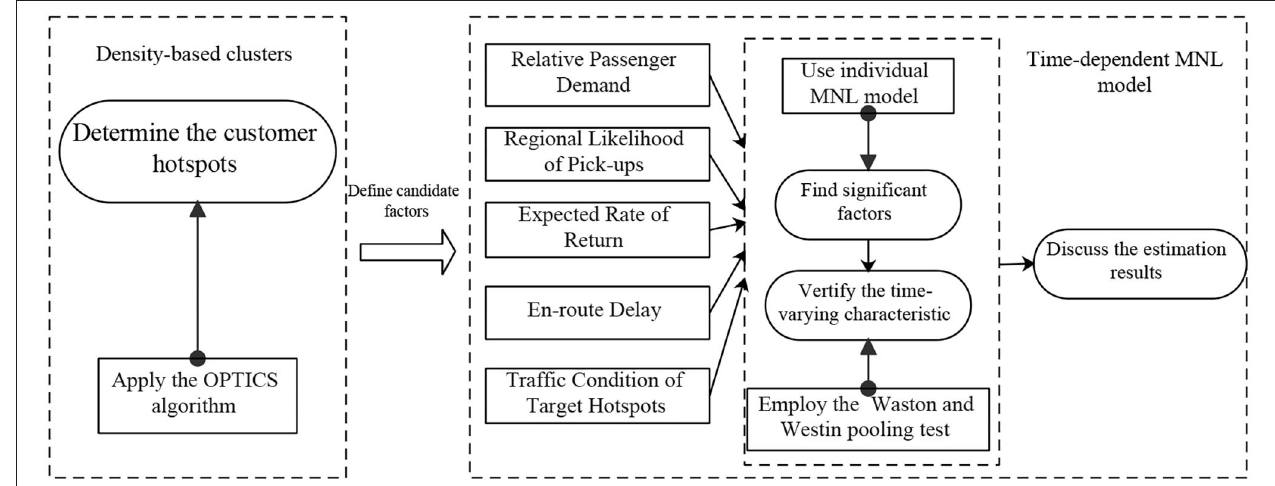
FIGURE 1 | Overview of study